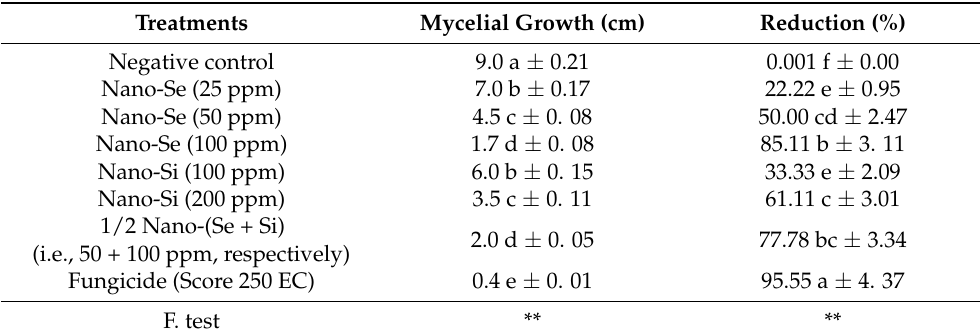
Table 3. Effects of the different treatments on mycelial growth of Alternaria alternata and the corre- sponding reduction in the pathogen under in vitro conditions in the lab.